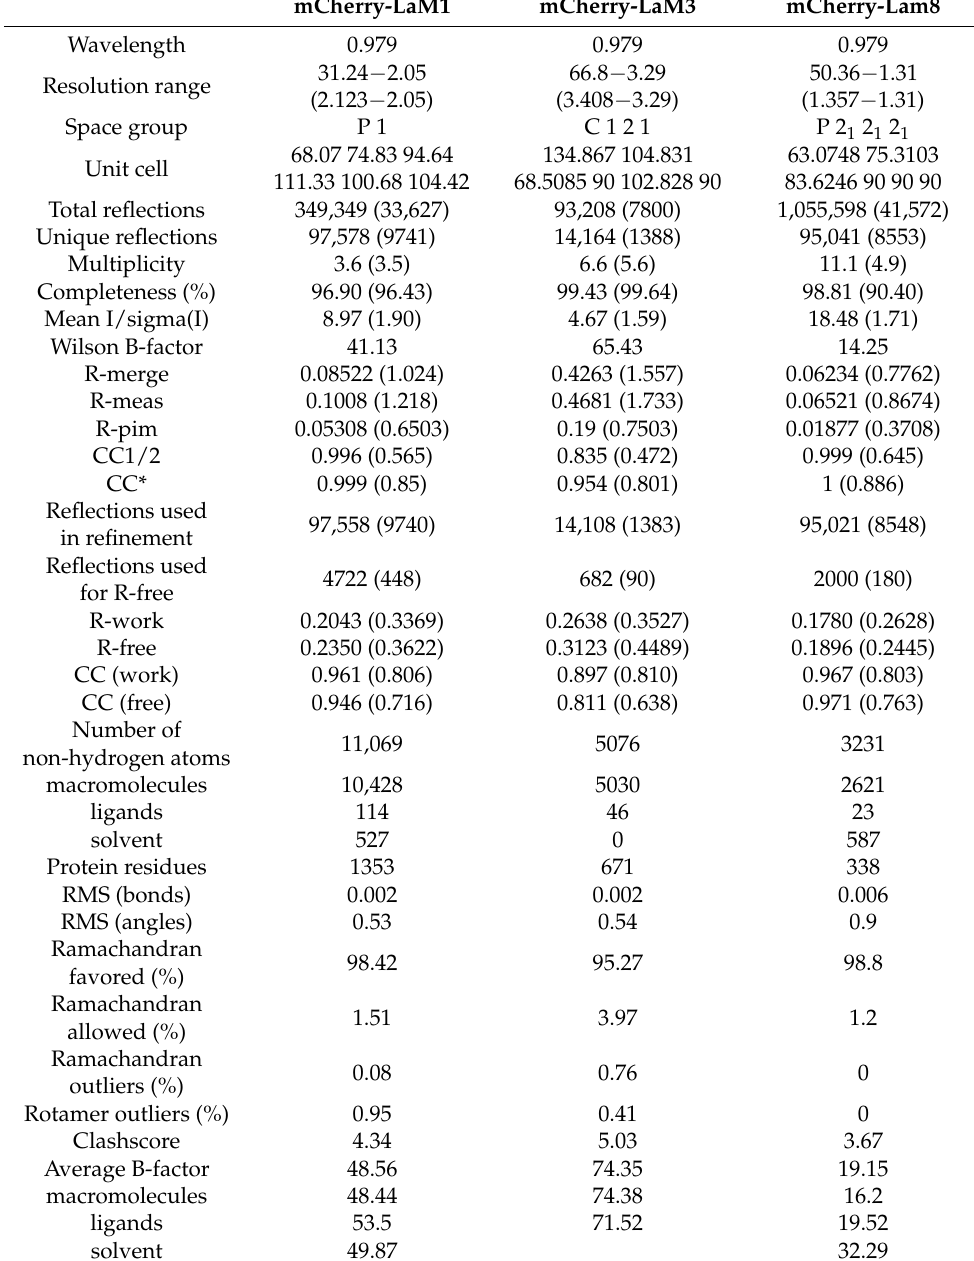
Table 1. Data collection and refinement statistics. The values in parentheses are for the high- resolution